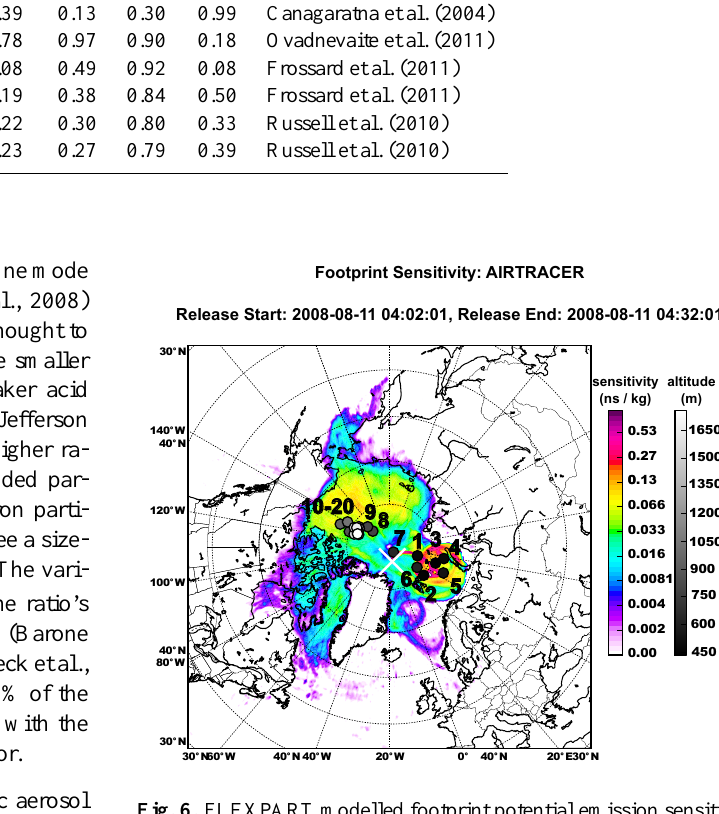
Fig. 6. FLEXPART modelled footprint potential emission sensitiv- ity for 11 August 2008, 03:20 (DOY 224.14). The Oden ’s position is marked by the white cross and the numbers show that the air was influenced by the Barents sea for 6 days before arriving at the Oden